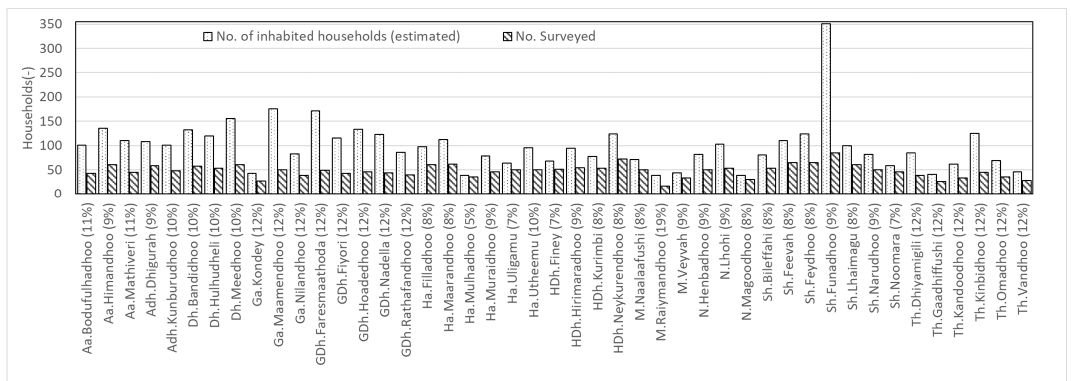
Figure 3. Demographics and sampling statistics of the 45 islands. The margins of error (MOE) at a 95% confidence level, with p = 0.5, are given in parenthesis. MOE for the total sample is <2%.